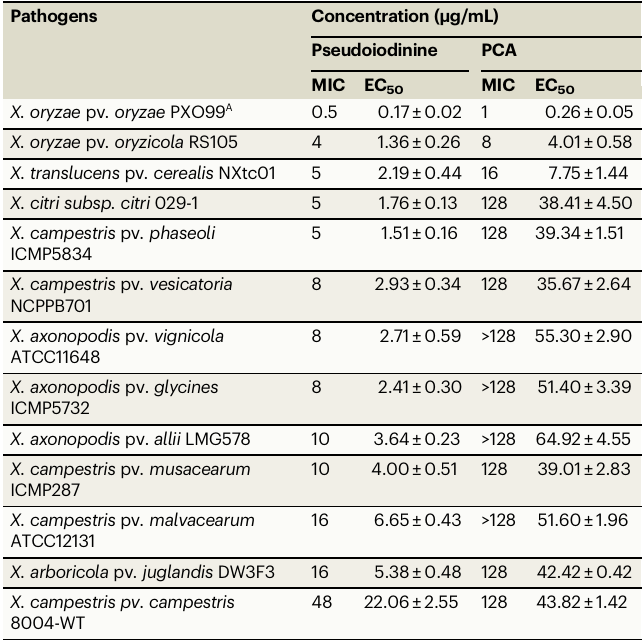
Table 1 | MIC and EC 50 values of pseudoiodinine and phenazine-1-carboxylic acid (PCA)